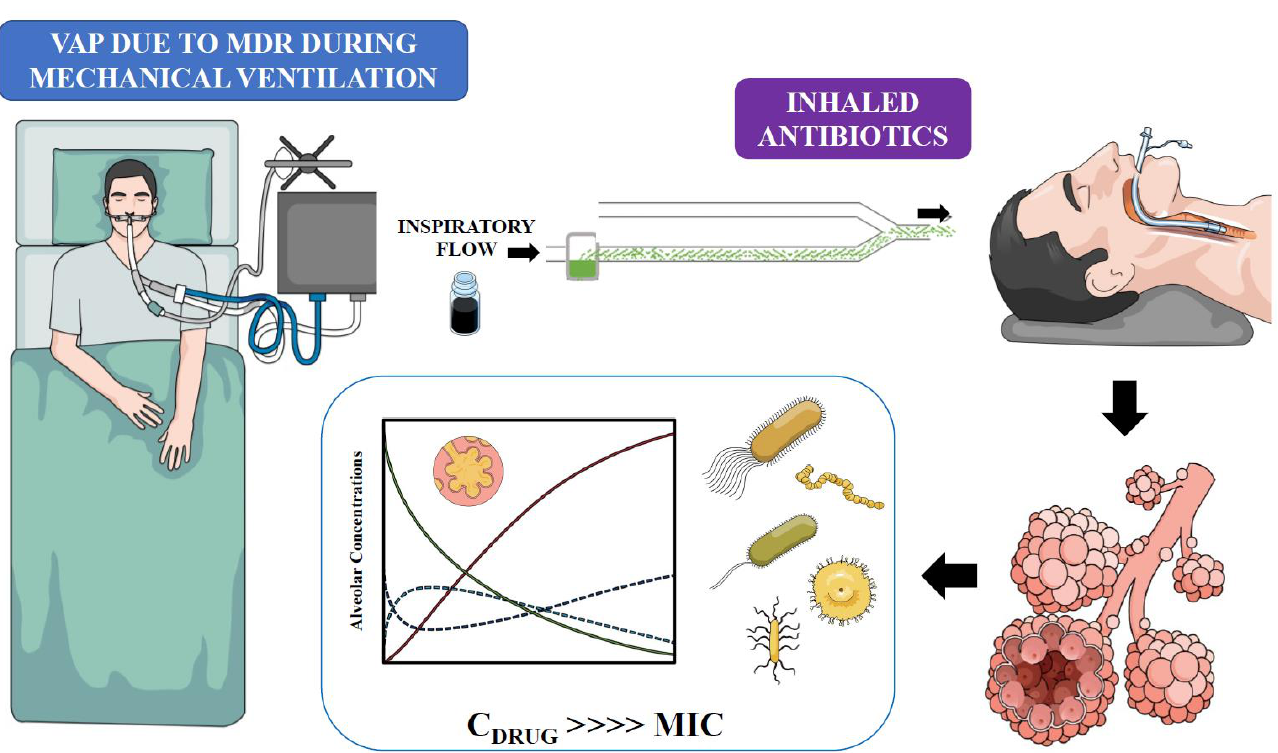
Figure 1. A simplified approach explaining the use of inhaled antibiotics for ventilator-associated pneumonia (VAP) due to multidrug-resistant (MDR) pathogens. Inhaled antibiotics will provide very high drug concentrations (C DRUG ) in the alveolar space, which by far exceed the minimal inhibitory concentration (MIC) of the pathogen.